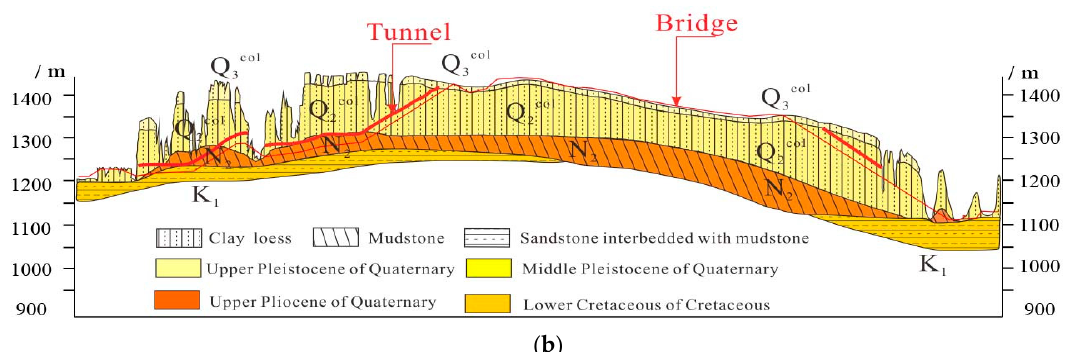
Figure 1. ( a ) Location map and ( b ) geological profile of the research area.